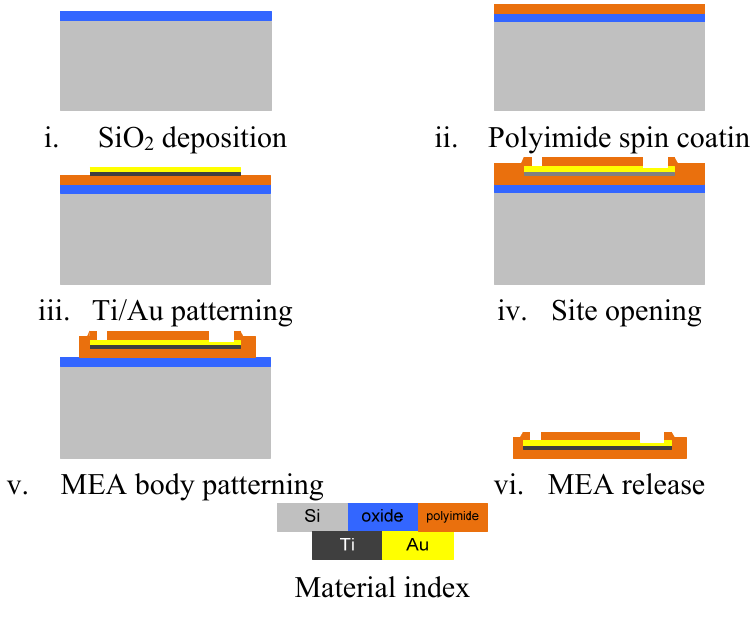
Figure 4. The fabrication process flow stimulating MEA.